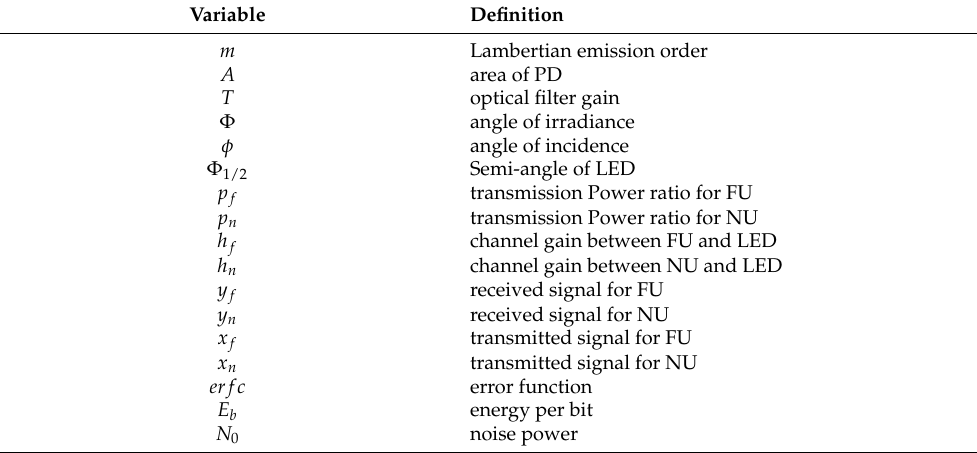
Table 1. Table for